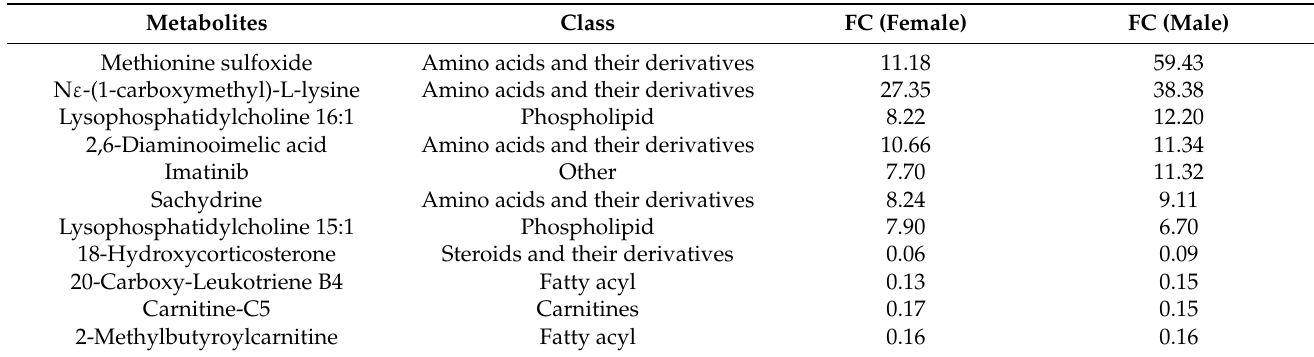
Table 2. Differential metabolites in the midgut of male and female silkworms fed on AD vs.